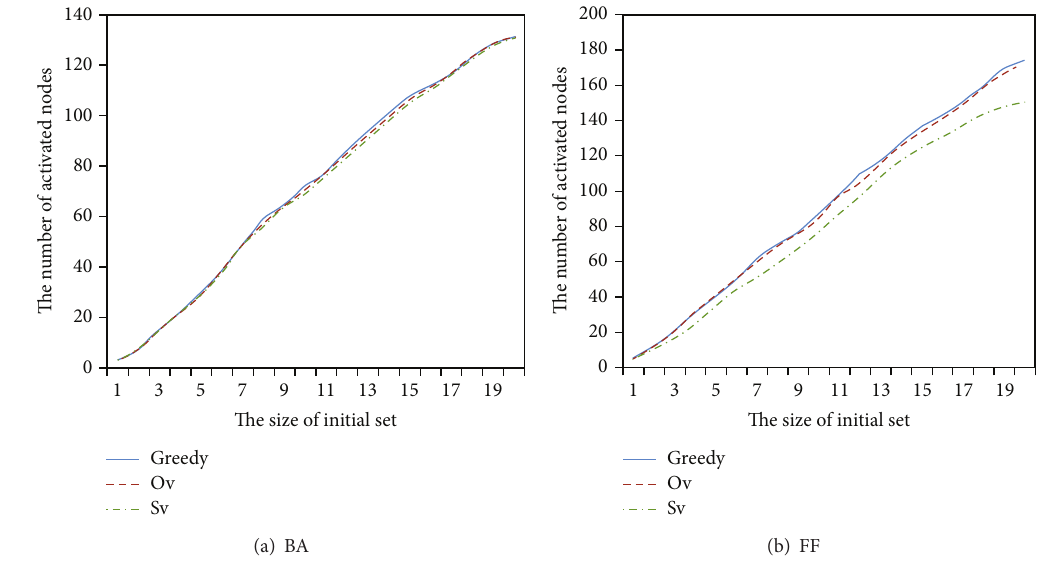
Figure 1: The influence of community structure on our method.